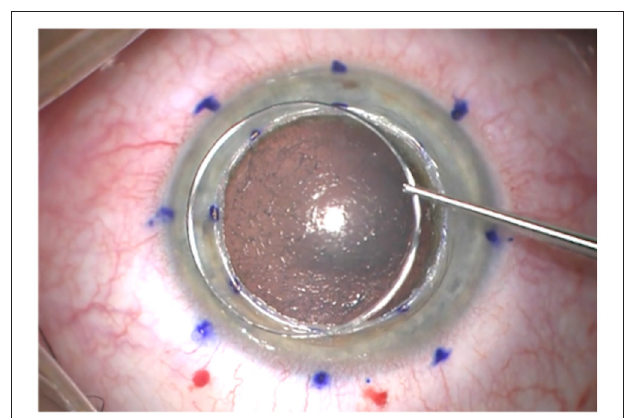
FIGURE 1 | Image of Neoring before